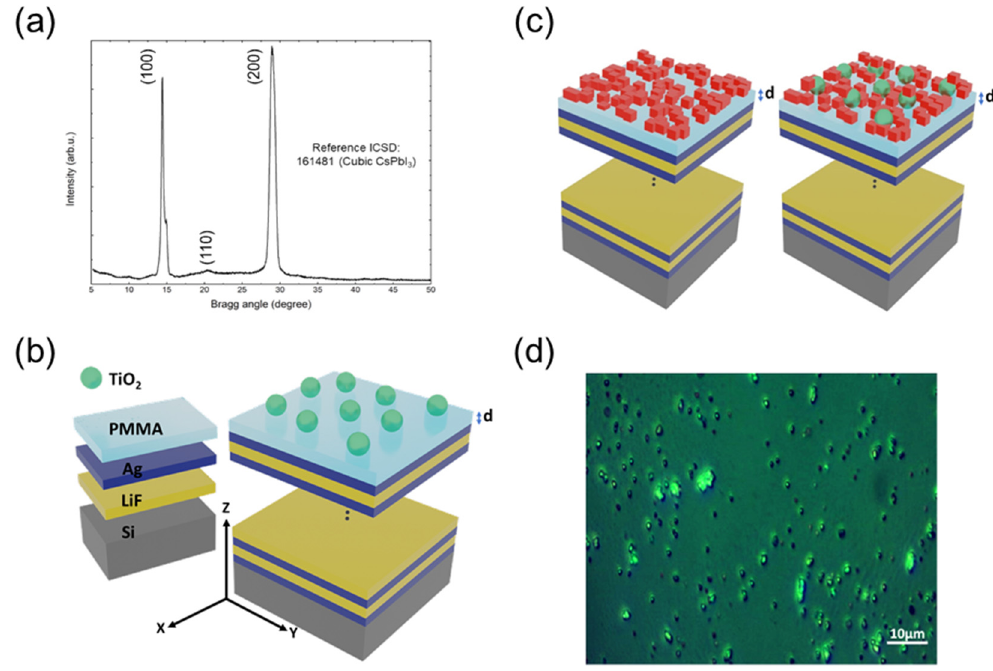
Figure 1. ( a ) XRD spectrum and analysis of CsPbI 3 PNCs. ( b ) Schematic representation of the HMM device with TiO 2 nanoresonators (green spheres) atop. ( c ) Schematic representation of HMM + PNCs (red cubes) and HMM + PNCs + nanoantenna, with a spacer layer of thickness d between them. ( d ) Optical microscope image of TiO 2 nanospheres dispersed on top of the HMM structure.